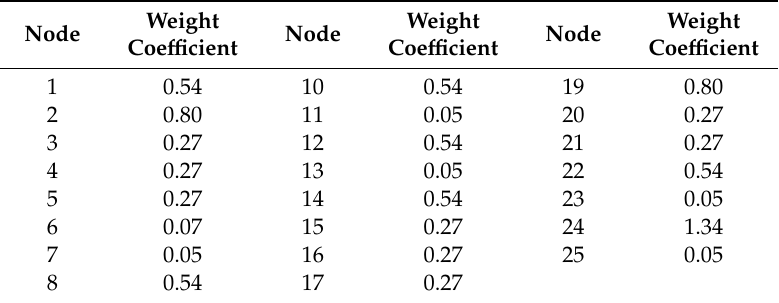
Figure 9. The 33-node distribution network. Table 3. Weight of various traffic nodes.